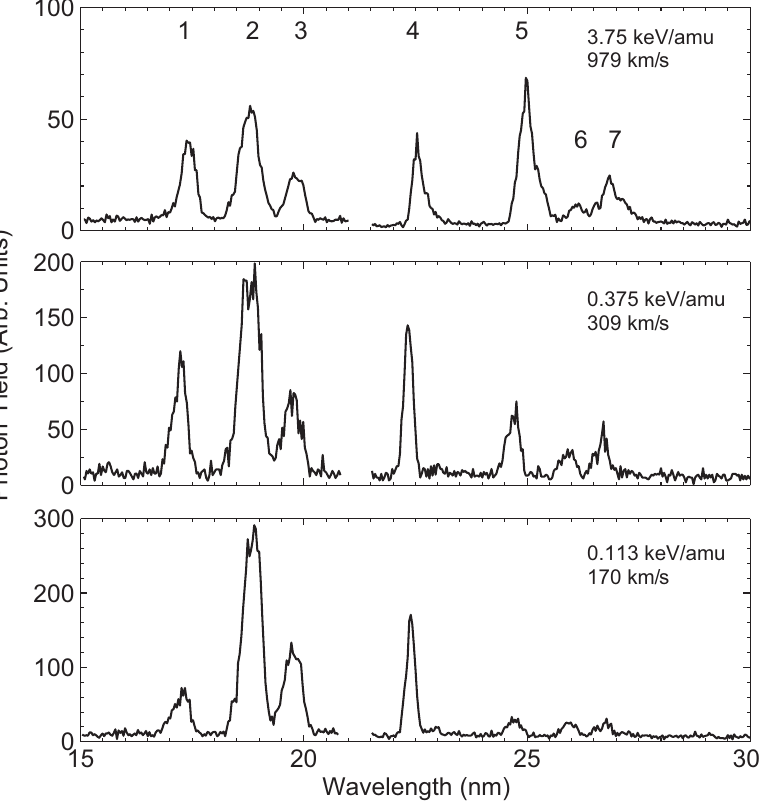
Figure 2. Charge-exchange spectra for collisions between C 5 + and H 2 O at different velocities. The numbers in the top of the figure marking the spectral lines refer to Table